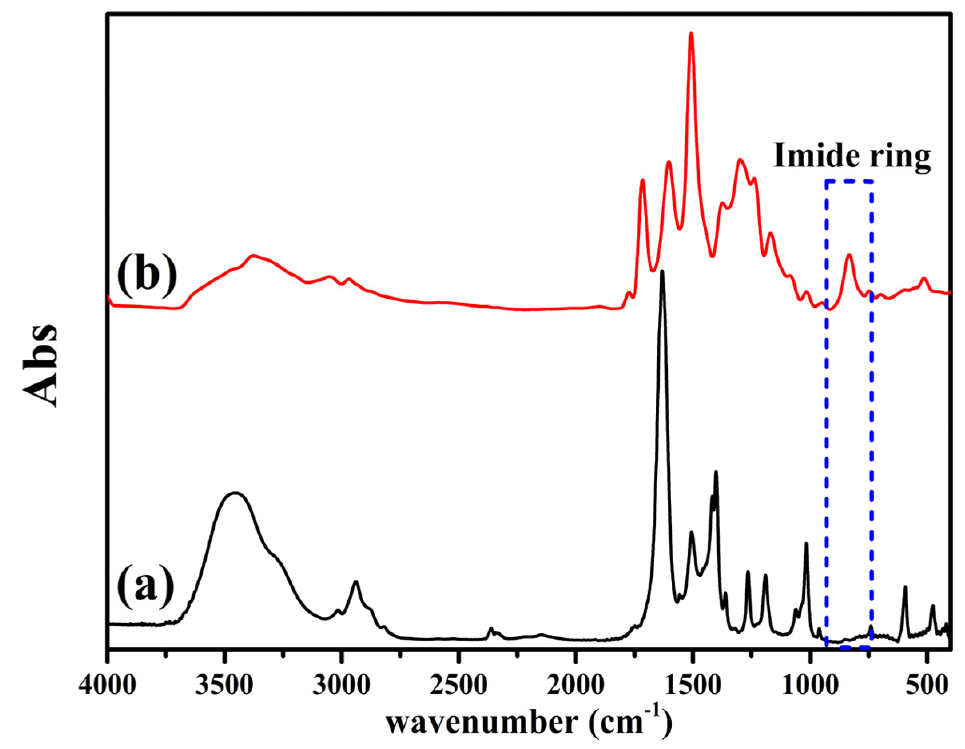
Figure 3. The representative FTIR spectra for ( a ) EPAA, ( b ) EPI.